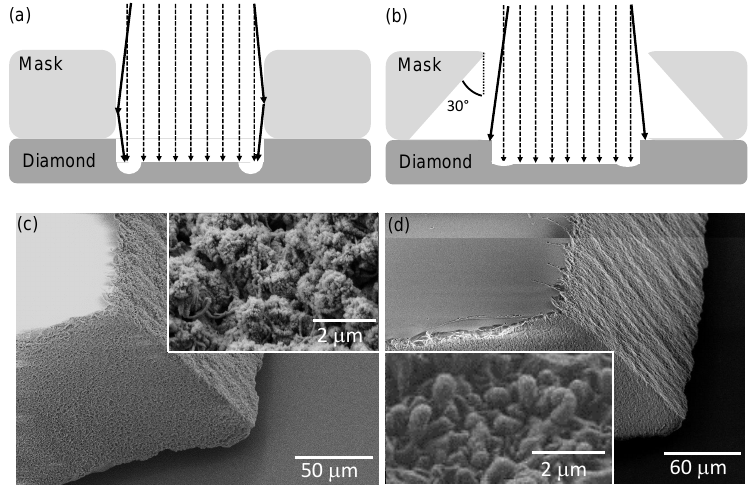
Figure 1. Quartz mask layout and morphology: ( a ) Formation of a trench close to the sidewalls: deflected ions (solid arrows) locally enhance the etch rate in comparison to regions that are only hit by non-deflected ions (dashed arrows); Part ( b ) depicts the improved mask layout and its effect on the trench formation. By cutting the mask’s sidewalls under an angle of roughly 30 ◦ , we avoid ion deflection on the mask’s sidewalls; Laser-cut quartz masks before ( c ) and after RIE cleaning ( d ) of the laser cut edge [low magnification images: etching time 30mins, plasma parameters see Table 1, SF 6 /Ar cleaning (O)]. A change of morphology indicates the removal of the deposit in the laser cut as discernible from the insets [inset: etching time 60min, plasma parameters see Table 1, SF 6 /Ar cleaning (S)]. Note that all masks initially undergo cleaning in a boiling tri-acid mixture (1:1:1 HNO 3 :H 2 SO 4 :HClO 4 , 5mL each) and subsequent ultrasonic cleaning in acetone and isopropanol to coarsely remove deposit and residual